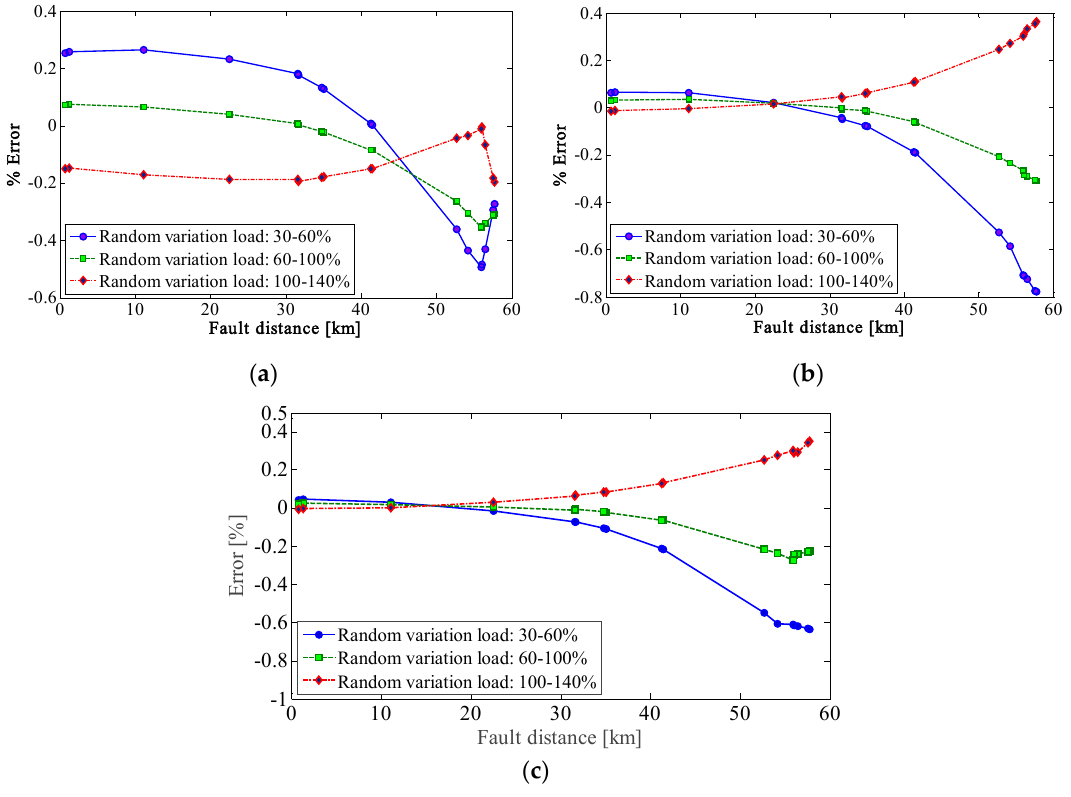
Figure 13. Performance curve for Scenario 2: ( a ) using the IEDs information, ( b ) using INIDER model instead of IEDs information, and ( c ) using the Inverter-interfaced DER model in limiting current mode instead of IEDs information.